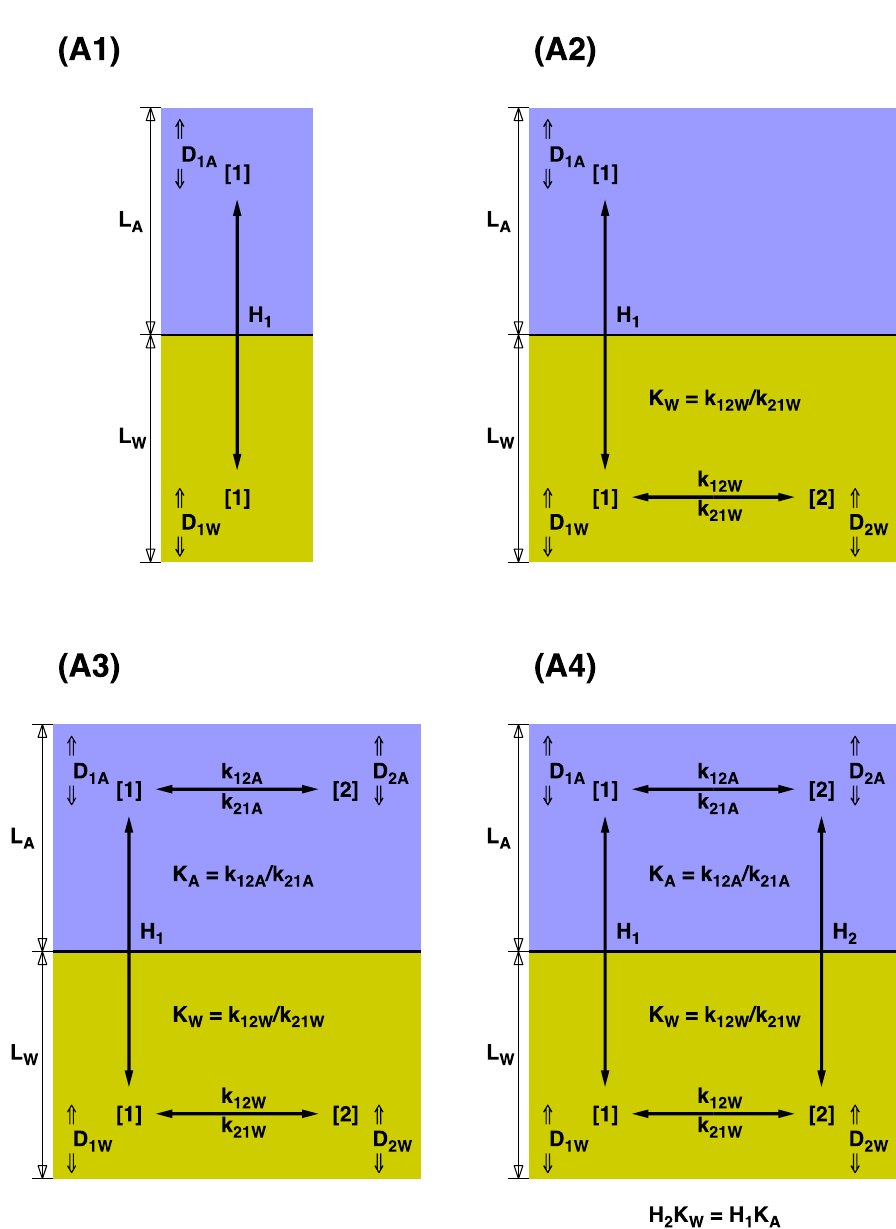
Figure 1. Four different models can be defined. A1 treats a single compound that does not react. Models A2, A3, and A4 assume that compound 1 reacts to form compound 2, either only in the water phase or in both phases. Model A4 also assumes that both forms, 1 and 2, are able to cross the interface. A1 is equivalent to Whitman [33], and A2 is equivalent to Hoover and Berkshire [54].